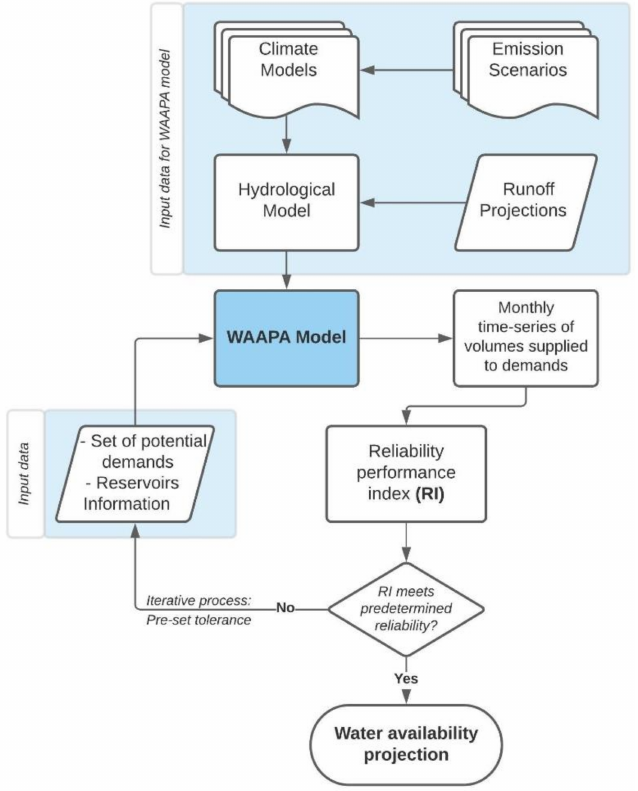
Figure 3. Diagram of the methodology applied to determine water availability with the WAAPA model